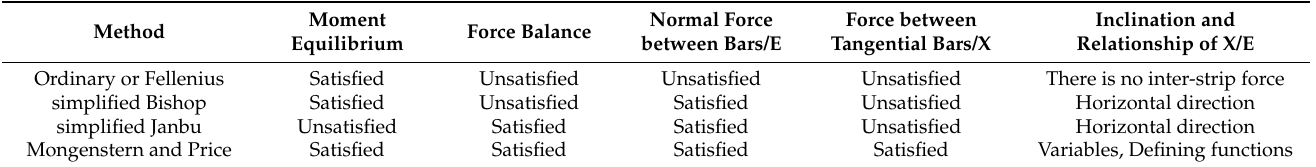
Table 3. Differences in limit equilibrium